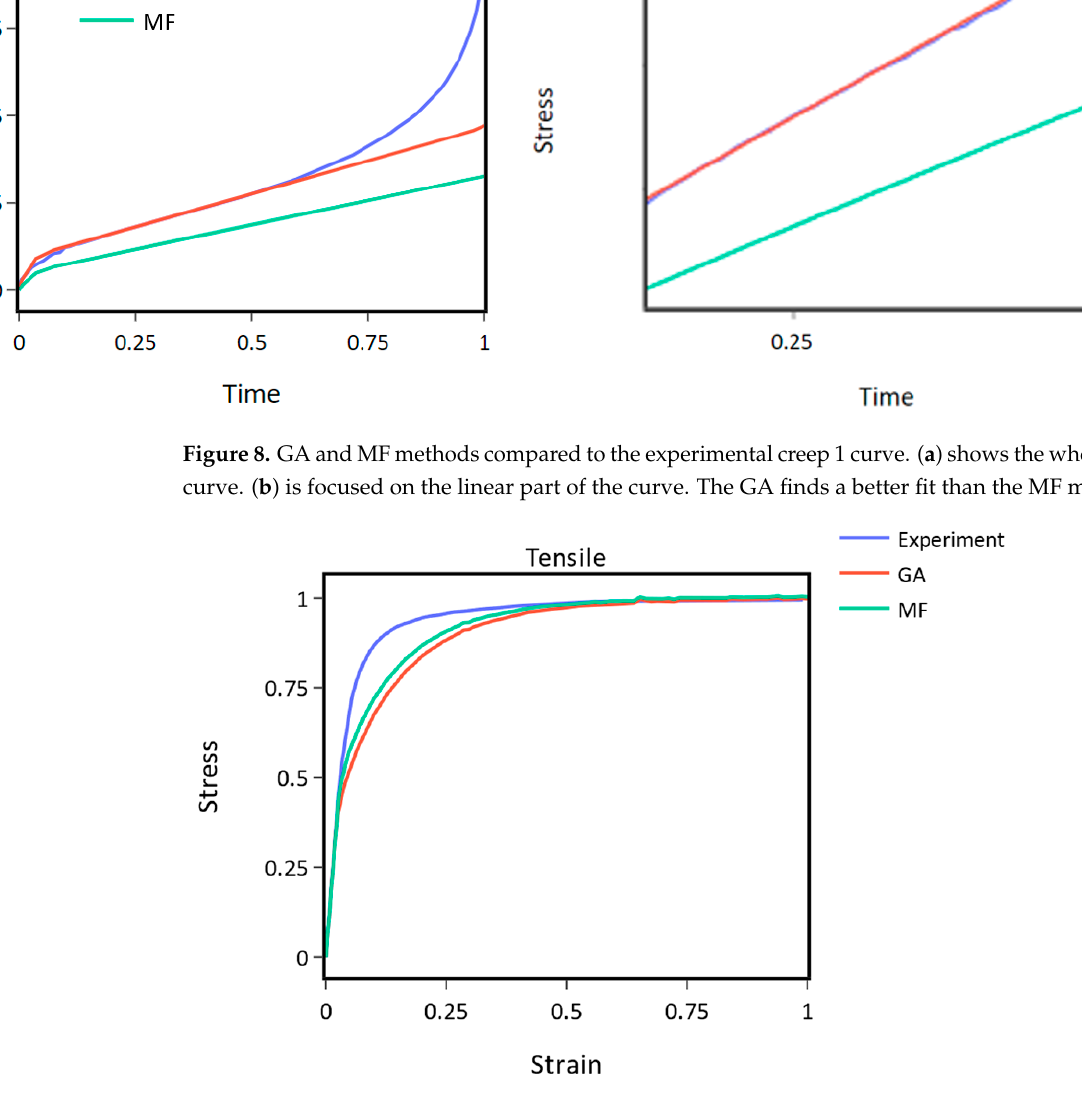
Materials 2023 , 16 , x FOR PEER REVIEW